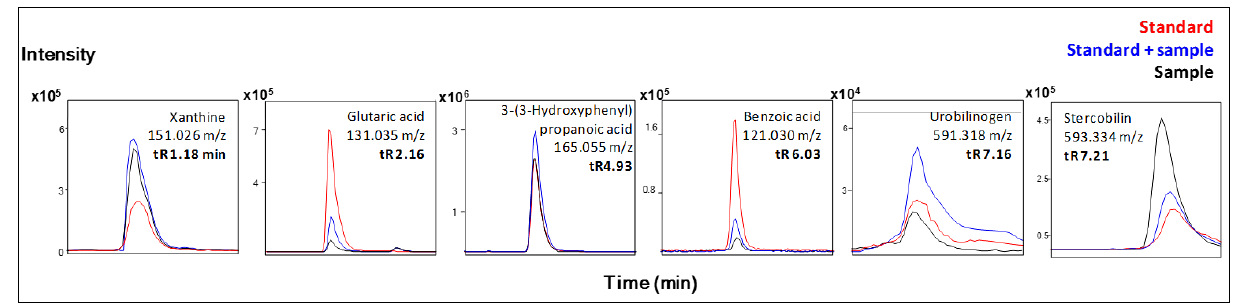
Figure 4. Extracted ion chromatograms of a fecal sample (black line), fecal sample spiked with 2.5 µg/mL 3-(3’-hydroxyphenyl) propionic acid, 1 µg/mL glutaric acid, 1 µg/mL benzoic acid, 1 µg/mL xanthine, 3.3 µg/mL stercobilin and 1.2 mg/mL urobilinogen (blue line) and commercial standard (red